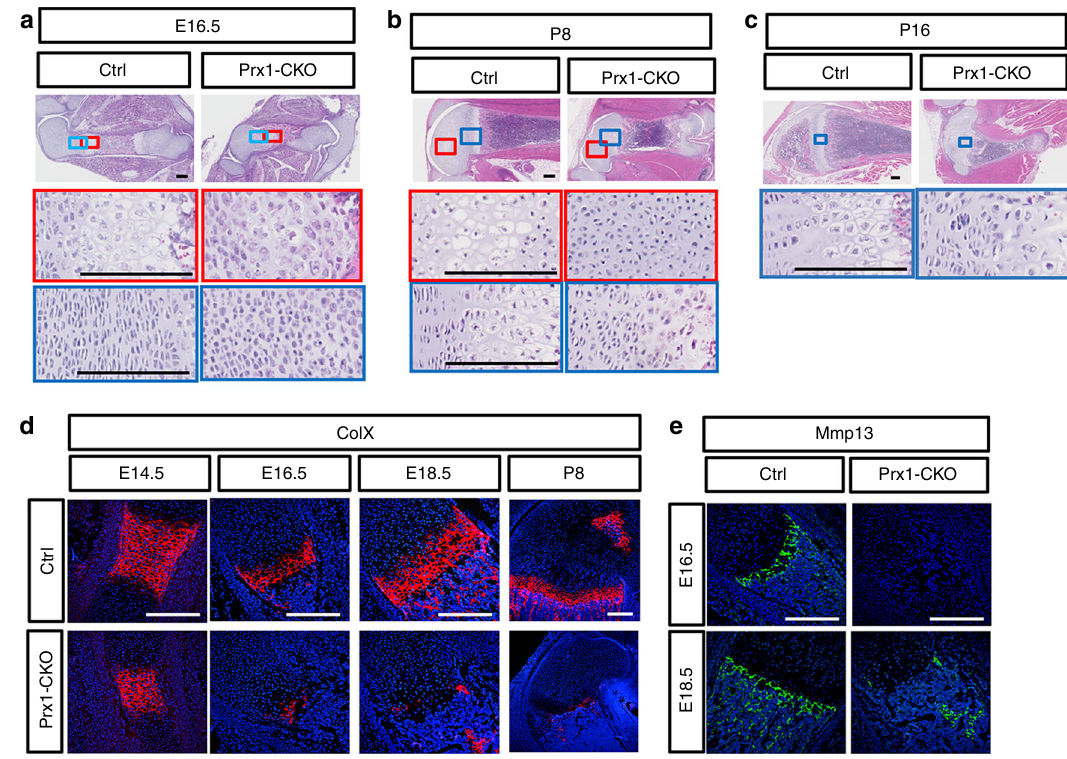
Fig. 3 Glut1 is indispensable for proper maturation of chondrocytes. a – e Histology of the femur at E16.5 ( a ), p8 ( b ), and p16 ( c ). Boxed areas shown at higher magni fi cation below. d , e Immuno fl uorescence staining of ColX ( d ) or Mmp13 ( e ). Scale bar: 200 µ m. Each image is representative of three mice